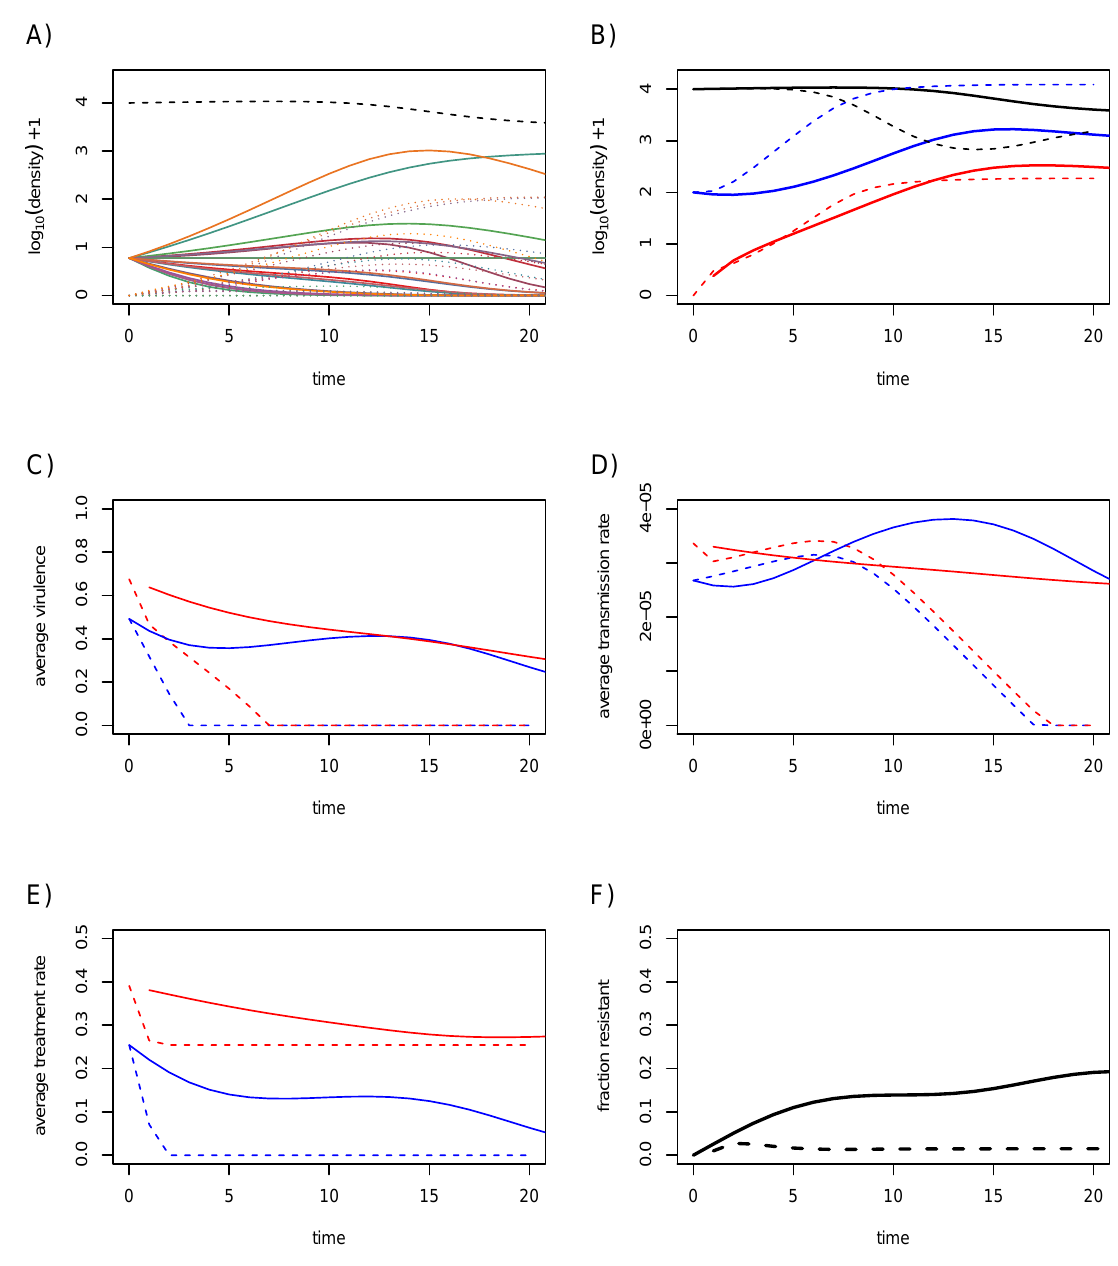
Figure S4 – Short-term evolutionary dynamics assuming noise in transmission rates. Fig- ure captions are identical to that in the main text. Parameter values are identical to that in the main text, except for the noise, which is generated by a Gaussian distribution cen- tred around the transmission value predicted by the trade-off shown in Figure S3B and with relative standard deviation